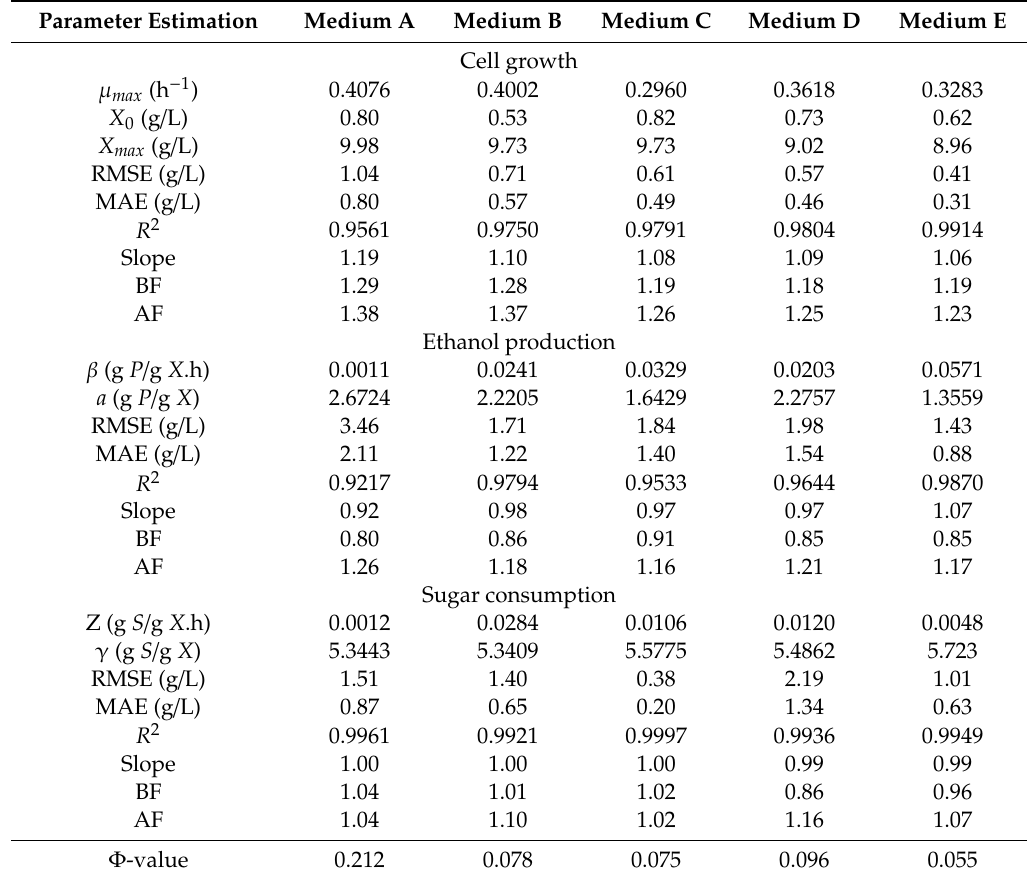
Table 1. The calculated model parameters for logistic, Luedeking-Piret (LP), and Modified Luedeking-Piret (MLP) equations.